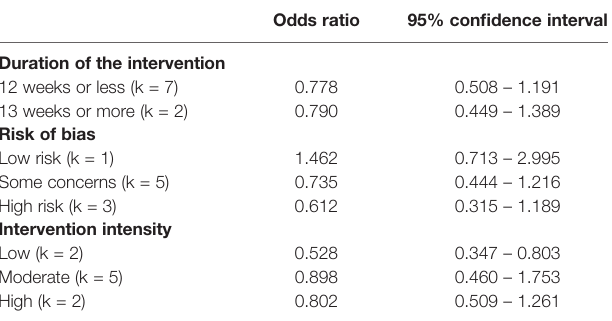
TABLE 5 | Subgroup